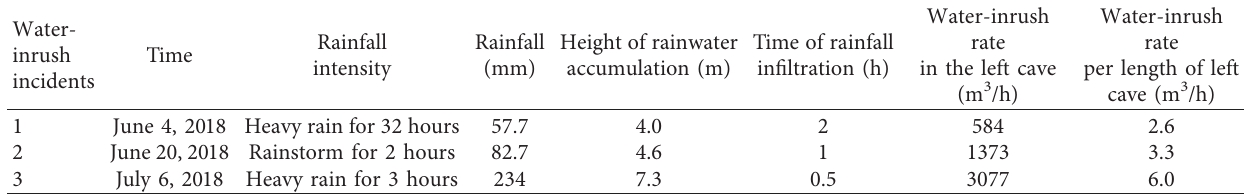
Table 10: Decoupling indexes of three water-inrush